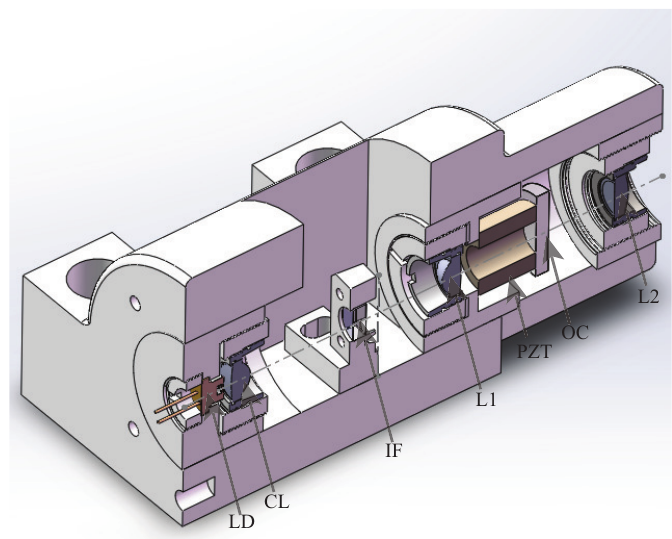
Figure 3. Computer-aided design view of the ECDL shown schematically in Figure 1. A sectional view is presented here to reveal the internal